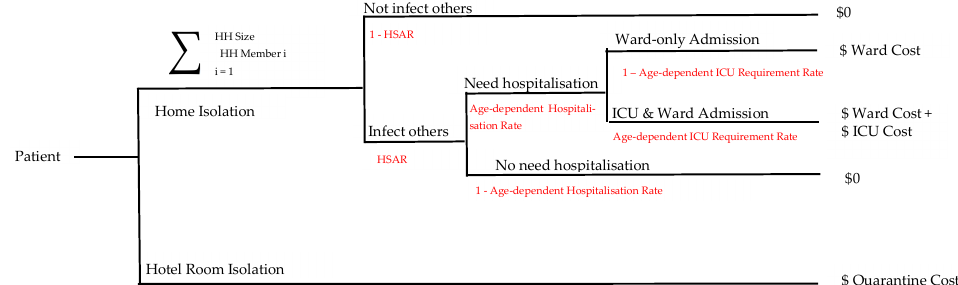
Figure 1. The decision tree of the cost-effectiveness analysis for case isolation in a hotel room versus self-isolation in the home. This figure is based on the cost-effectiveness analysis of isolating a case with mild symptoms in the hotel versus in the home. Clearly, household size and the housemates’ ages will determine the hospitalisation and ICU requirement rates.